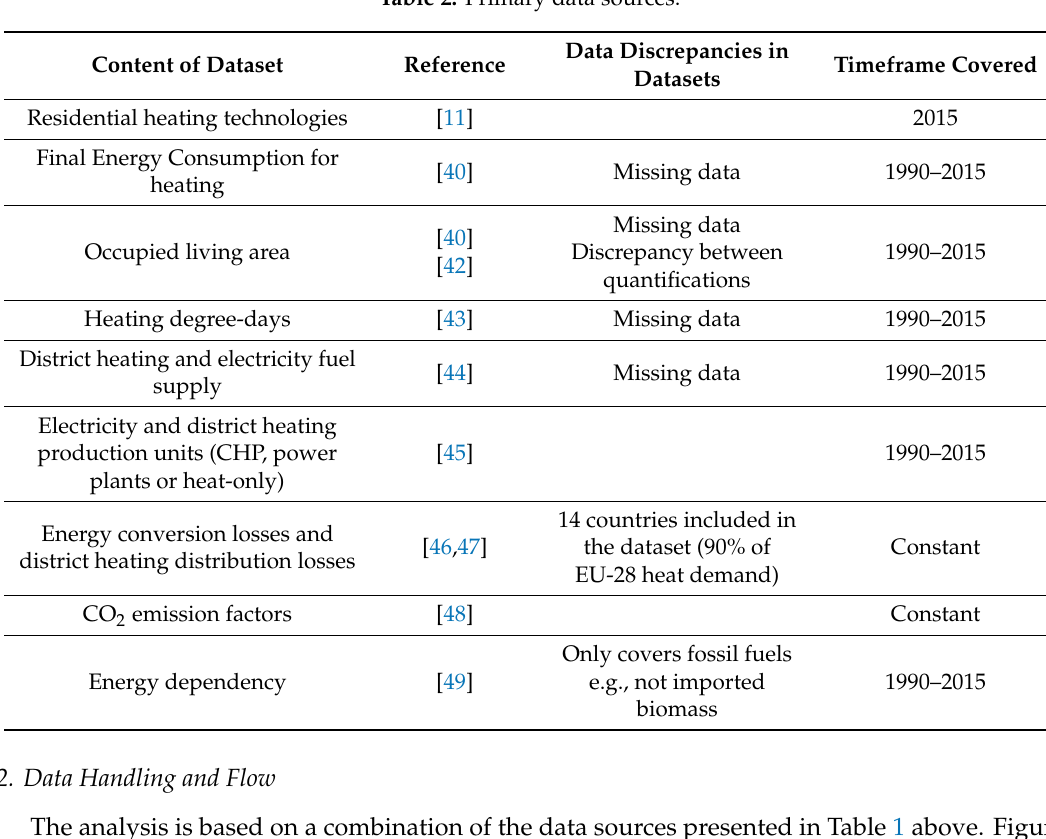
Table 2. Primary data sources.